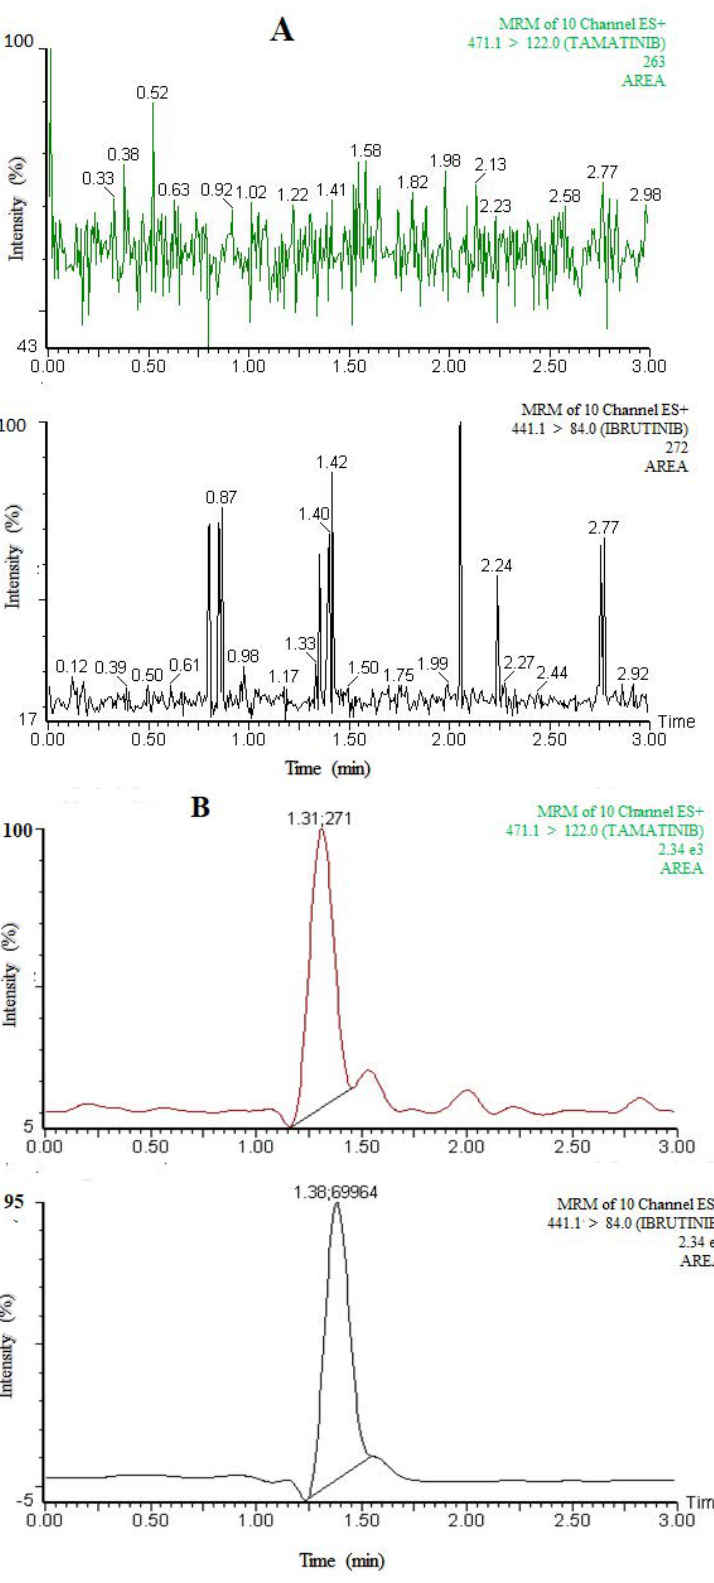
Figure 2. MRM Chromatograms of Tamatinib and Internal Standard in Blank Rat Plasma ( A ), and Plasma Spiked at LLOQ Level ( B